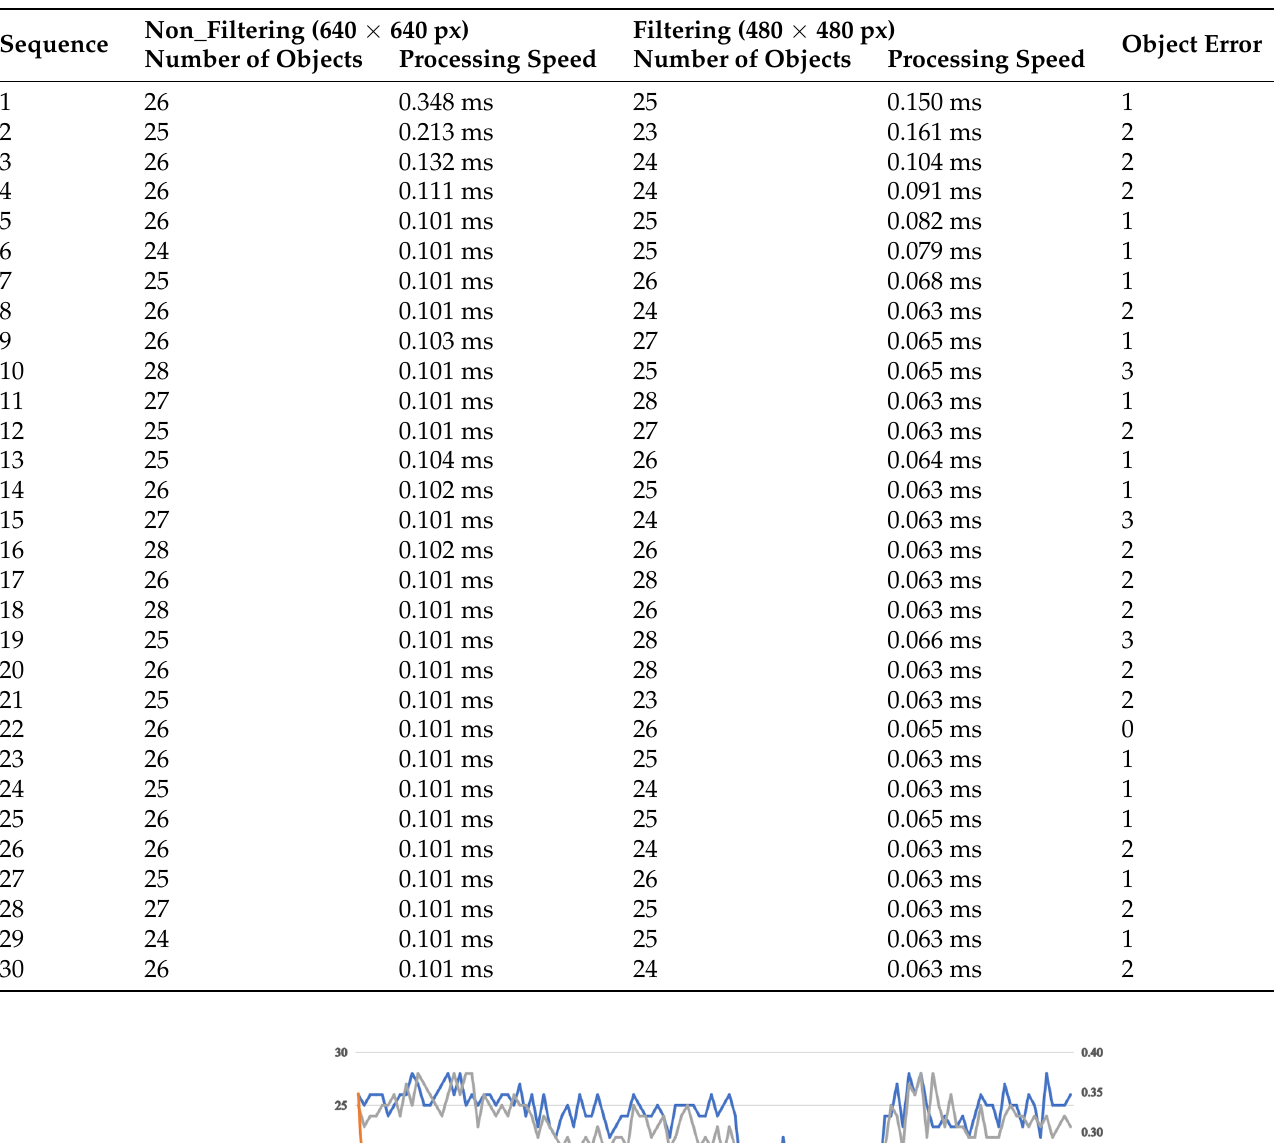
Table 5. Performance comparison table before and after filtering.